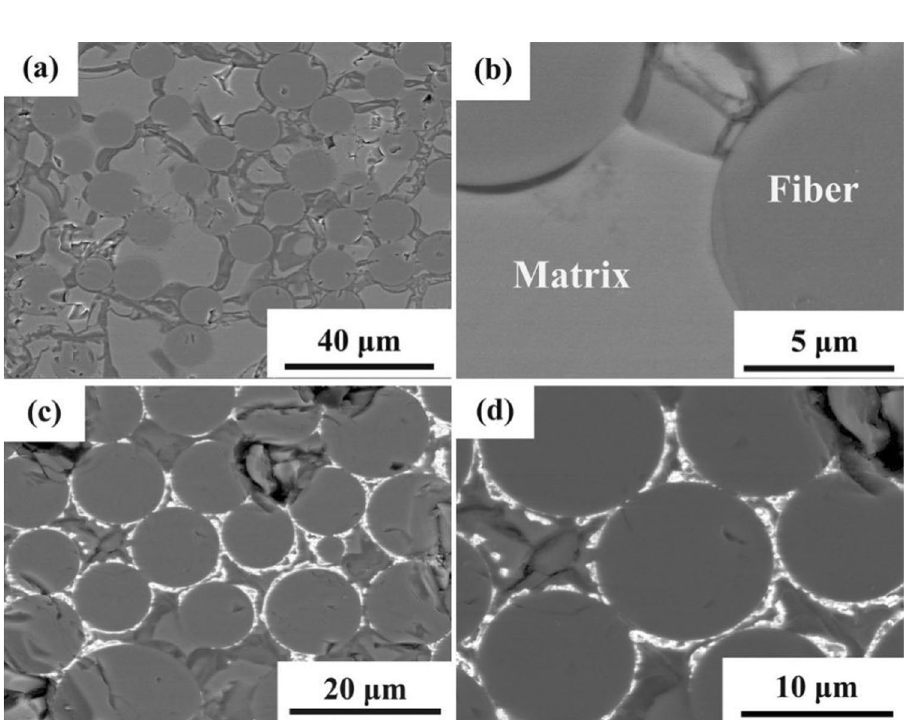
Figure 6. Cross-section view of SiC f /SiC minicomposites: ( a , b ) without interphase coating and ( c , d ) with CaWO 4 interphase